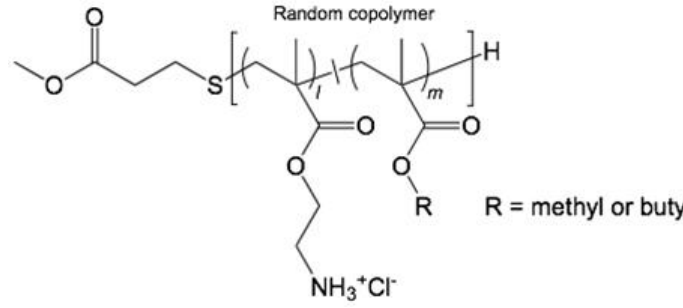
Figure 1. Chemical structure of amphiphilic polymethacrylate derivatives